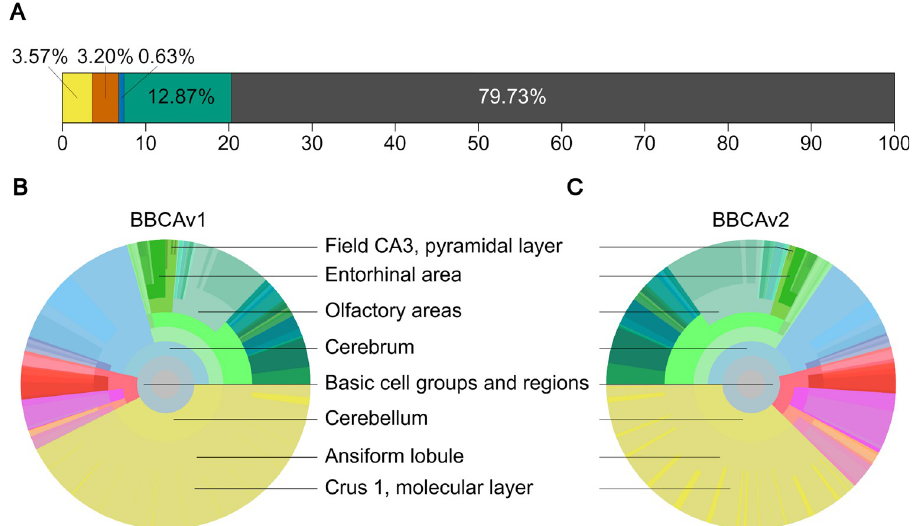
Fig 7. Distribution of the GABAergic neurons in the mouse brain. (A) Ratios of PV+, SST+, VIP+, GAD67+, and remaining neurons of the mouse brain. InhR cells appear in green, PV+ in yellow, SST+ in orange, and VIP+ in blue. The remaining neurons appear in grey. (B), (C) Circular distribution of GAD67+ neurons in different regions of the mouse brain according to different parcellation schemes ranging from coarse at the center to fine-grained at the periphery (colors and disposition similar to Fig 4A). (B) displays results of BBCAv1 and (C) results of